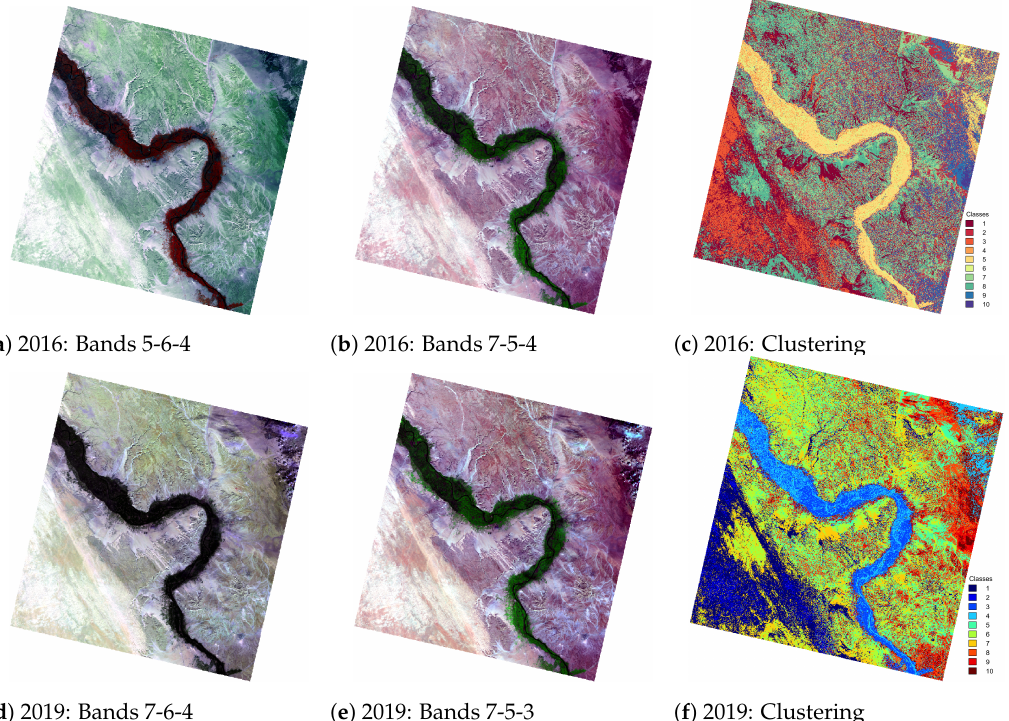
Figure 8. Qena Bend of the Nile River: false color composites and clustering of the Landsat 8-9 OLI/TIRS images: ( a ) 2016 RGB in 5-6-4 Bands, ( b ) 2016 RGB in 7-5-4 Bands, ( c ) 2016 unsupervised classification, ( d ) 2019 RGB in 7-6-4 Bands, ( e ) 2019 RGB in 7-5-3 Bands, ( f ) 2019 RGB: Clustering.